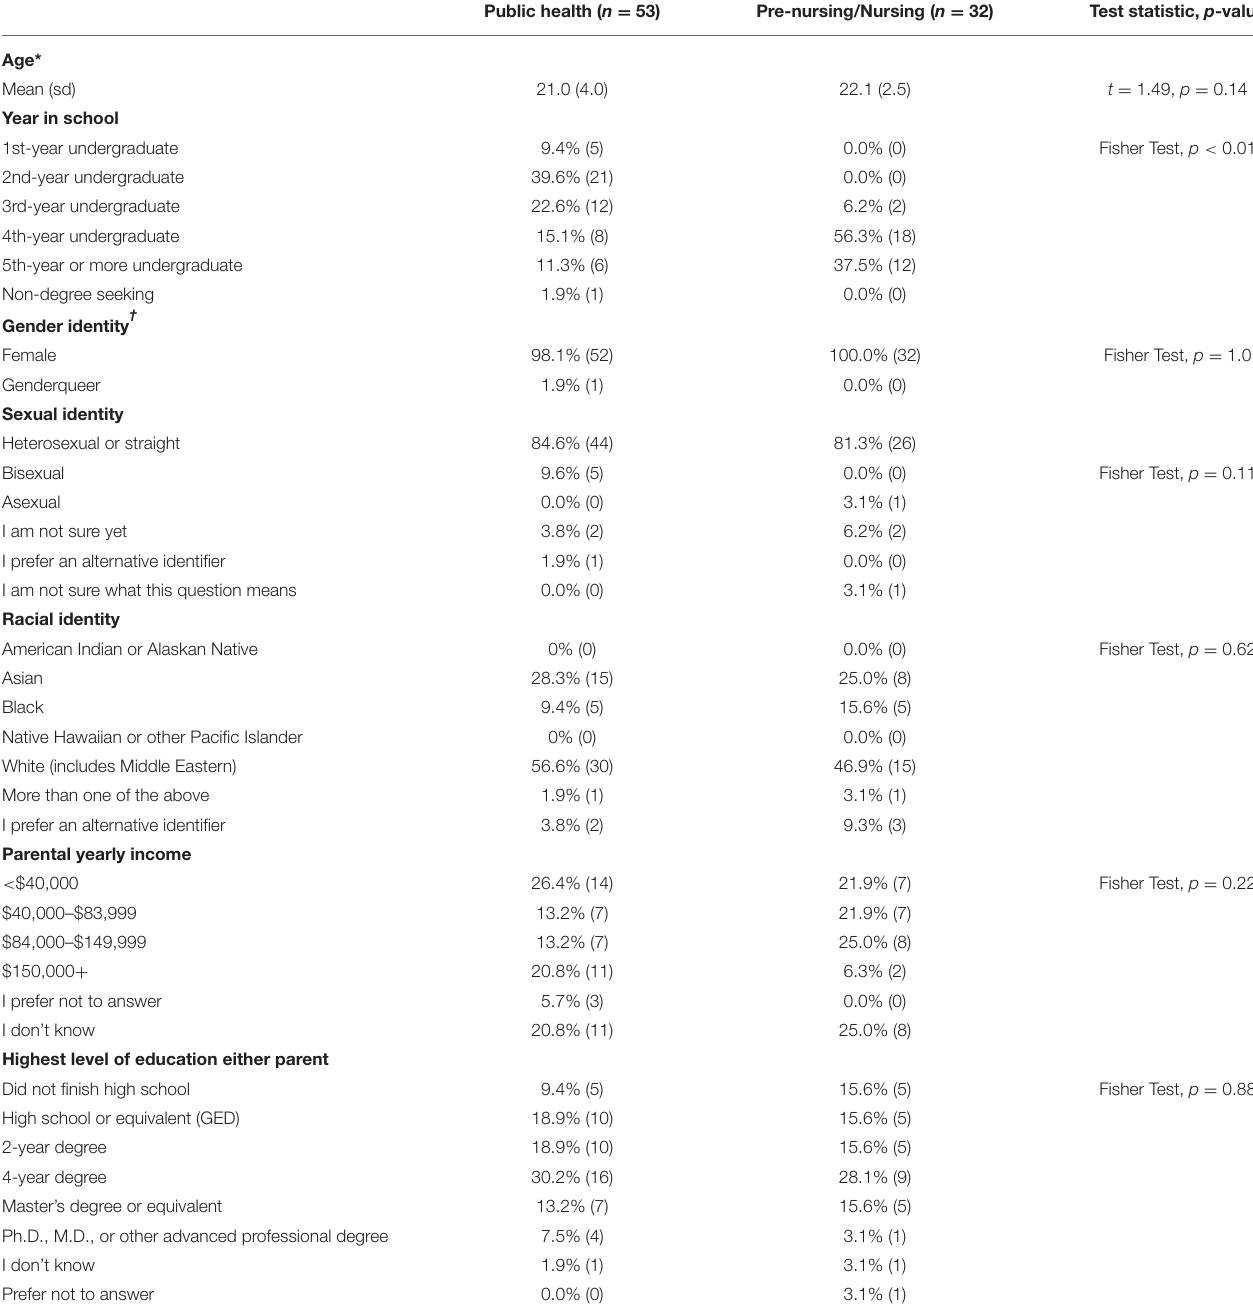
TABLE 1 | Survey respondent characteristics by